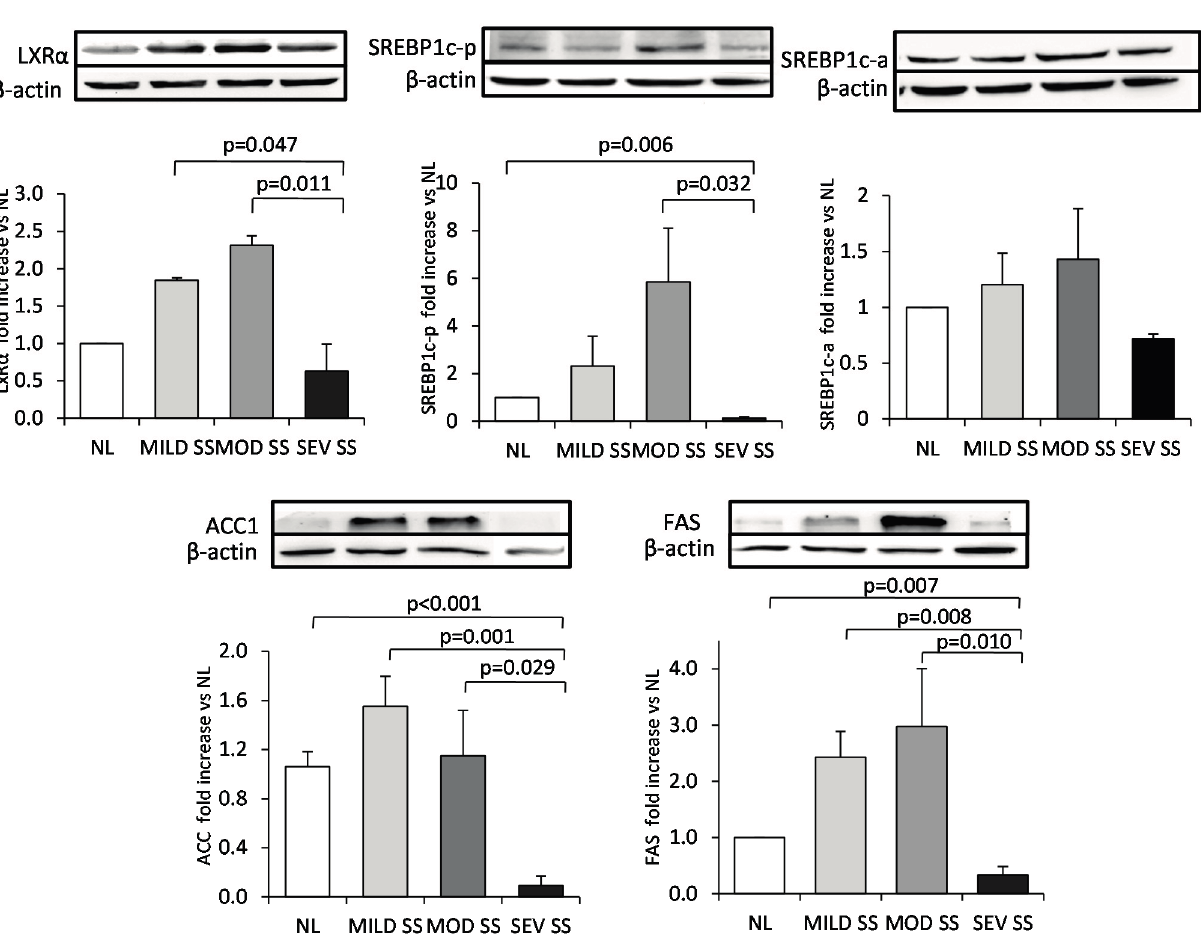
Figure 1. Liver expression of lipogenic transcription factors and enzymes in morbidly obese patients diagnosed with different degree of simple steatosis. Representative Western blot analysis showing LXR α , SREBP1c-precursor form (SREBP1c-p), SREBP1c-active form (SREBP1c-a), ACC1, FAS and β -actin protein expression and bar graphs showing the quantification of bands normalized by values of β -actin bands ( n = 28: 6 NL, 8 MILD SS, 8 MOD SS, 6 SEV SS). Results are shown as mean ± SD. p < 0.05 are considered statistically significant. NL, morbidly obese subjects with normal liver; MILD SS, morbidly obese subjects with mild simple steatosis; MOD SS, morbidly obese subjects with moderate simple steatosis; SEV SS, morbidly obese subjects with severe simple